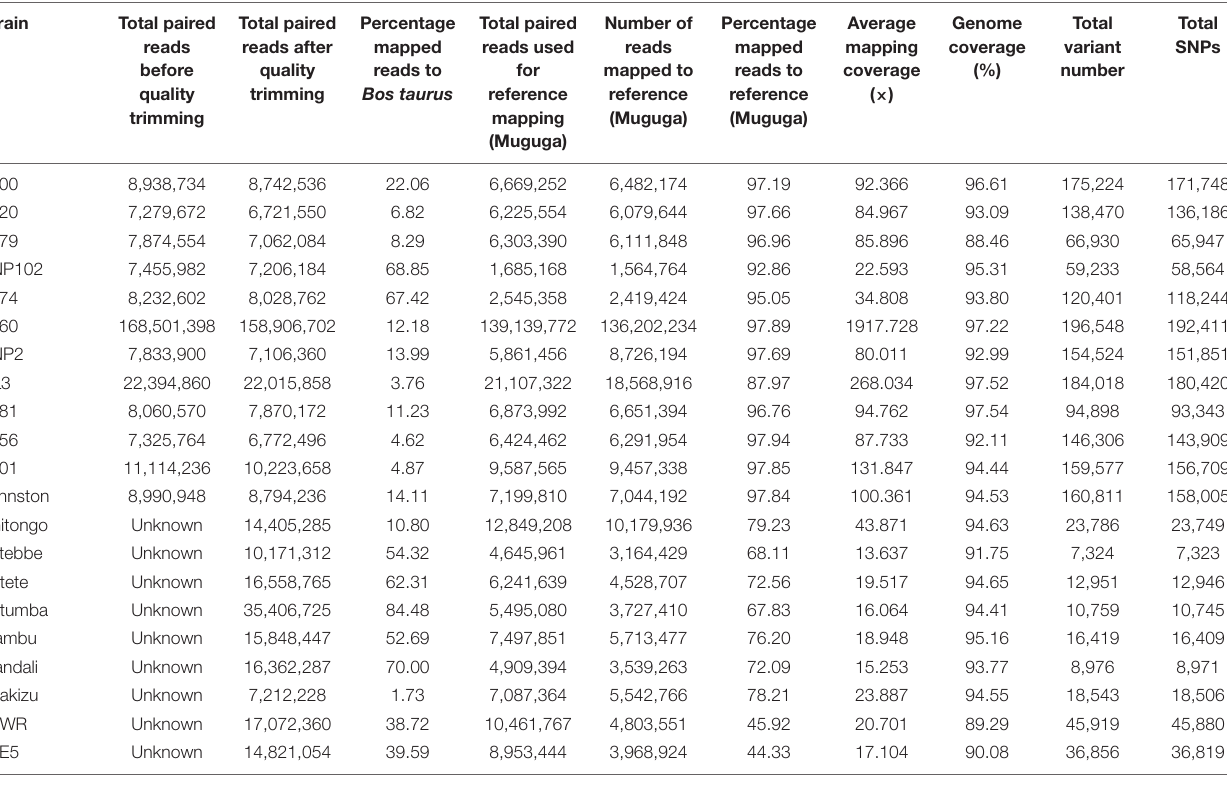
TABLE 3 | Mapping and sequencing statistics of different Theileria parva strains used in this study. Strain